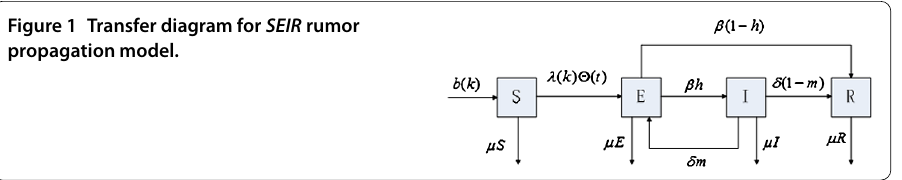
Figure 1 Transfer diagram for SEIR rumor propagation